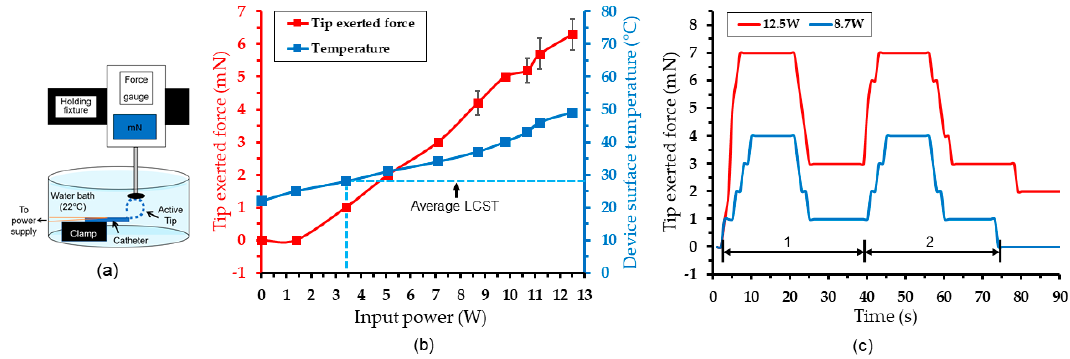
Figure 10. Actuation force characterization: ( a ) Measurement set-up used; ( b ) measured forces as a function of input power (measured device surface temperature from Figure 6b included for comparison); ( c ) temporal force response measured with two different input powers.